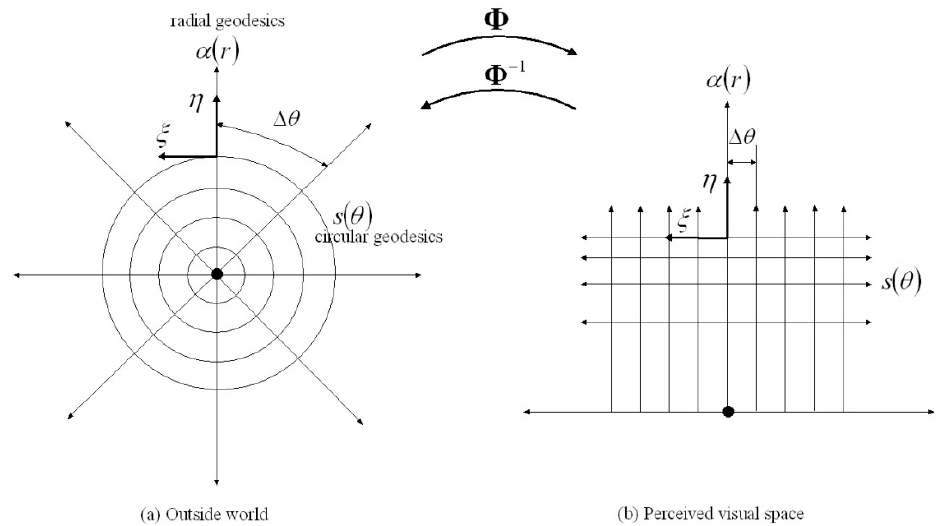
Figure 1. An illustration of the smooth conformal mapping Φ between ( a ) cylindrical coordinates ( r , θ ) on any plane in the 3D Euclidean outside world passing through the egocentre represented by the dot • at the origin and ( b ) the corresponding plane in the warped Riemannian geometry of 3D visual space with the egocentre again represented by • . Φ maps circular geodesics s ( θ ) and radial geodesics α ( r ) intersecting at right angles in the Euclidean outside world to corresponding horizontal straight lines s ( θ ) and vertical straight lines α ( r ) intersecting at right angles in the perceived visual space. The vectors ξ are Killing vectors whose integral flows preserve the metric g . The vectors η = are velocity vectors tangent to the radial geodesics α ( r ) . Φ − 1 depicts the inverse mapping from ( b ) to ( a ) and corresponds to the transformation applied by Linton. Notice that arc lengths s = r ∆ θ in the outside world increase linearly with Euclidean distance r while the corresponding spacing along the horizontal lines in visual space is constant. Also notice that a linear increase in radial distance r in the outside world corresponds to a logarithmic decrease in distance in visual space. The difference between the two coordinate systems illustrates the profound warping of visual space attributable to the anatomy and physiology of the eye. The warping is consistent with the perceived size of objects in visual space being proportional to the angle subtended at the egocentre by the object in the outside world.